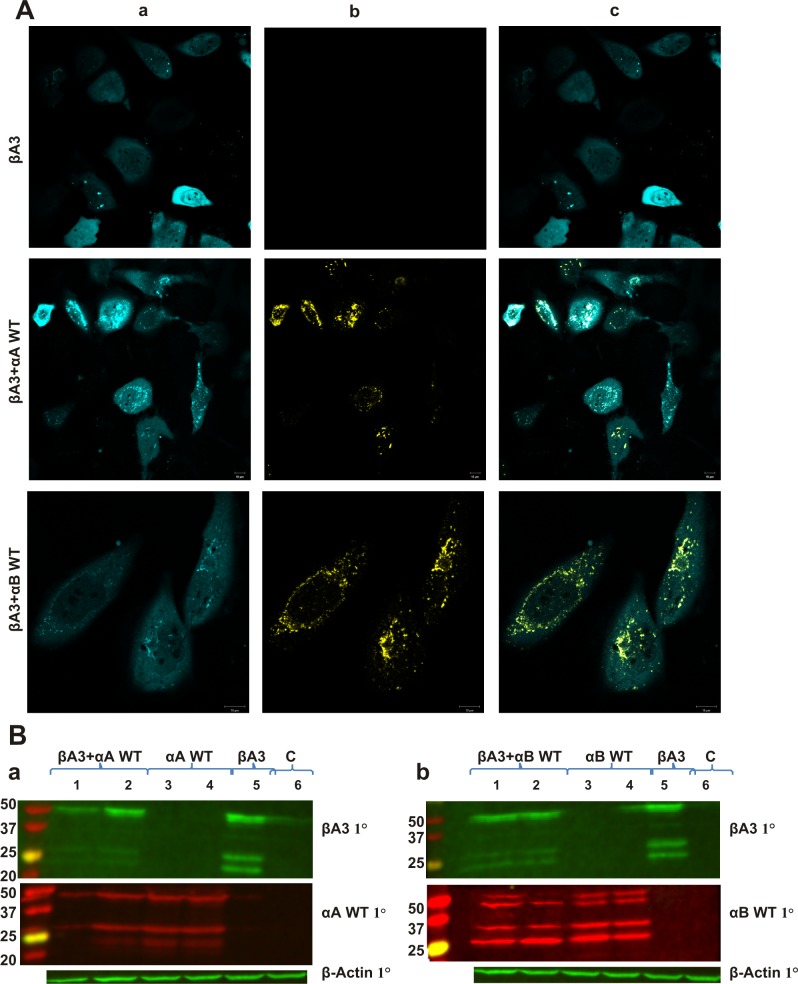
Confocal images of expression of αA- and WT αB- crystallin with βA3- crystallin in HeLa cells.Confocal microscopic images of transfected HeLa cells with: A. CFP βA3-crystallin alone and co-transfected with CFP βA3-crystallin-YFP WT αA-crystallin; and CFP βA3-crystallin-YFP WT αB-crystallin. Note the co-expression of CFP- and YFP-tagged crystallins. Panel a: CFP channel image of cells co-transfected with pairs of CFP- and YFP-fusion crystallins Panel b: YFP channel image of cells co-transfected with pairs of CFP- and YFP- fusion crystallins Panel c: Merged images for CFP- and YFP-channels of cells co-transfected with pairs of CFP- and YFP-fusion crystallins. Note that in case of CFP βA3-crystallin alone, no-bleed through expression of YFP was observed. B. Western blot analysis of the expression of a. CFP βA3-crystallin and YFP WT αA-crystallin Lanes 1 and 2: αA+ βA3, lanes 3 and 4: αA-, lane 5: βA3, Lane 6:Control. b. CFP βA3-crystallin and YFP WT αB-crystallin Lanes 1 and 2: αB+ βA3, lanes 3 and 4: αB-, lane 5: βA3, lane 6:Control. using βA3-1° antibody (green) and αA/ αB 1° antibody (red). β-actin was used as a loading control.